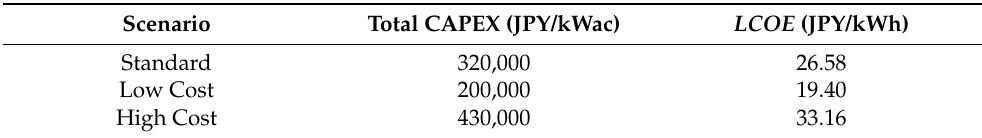
Table 8. Mesh areas of abandoned farmland detected in this study.